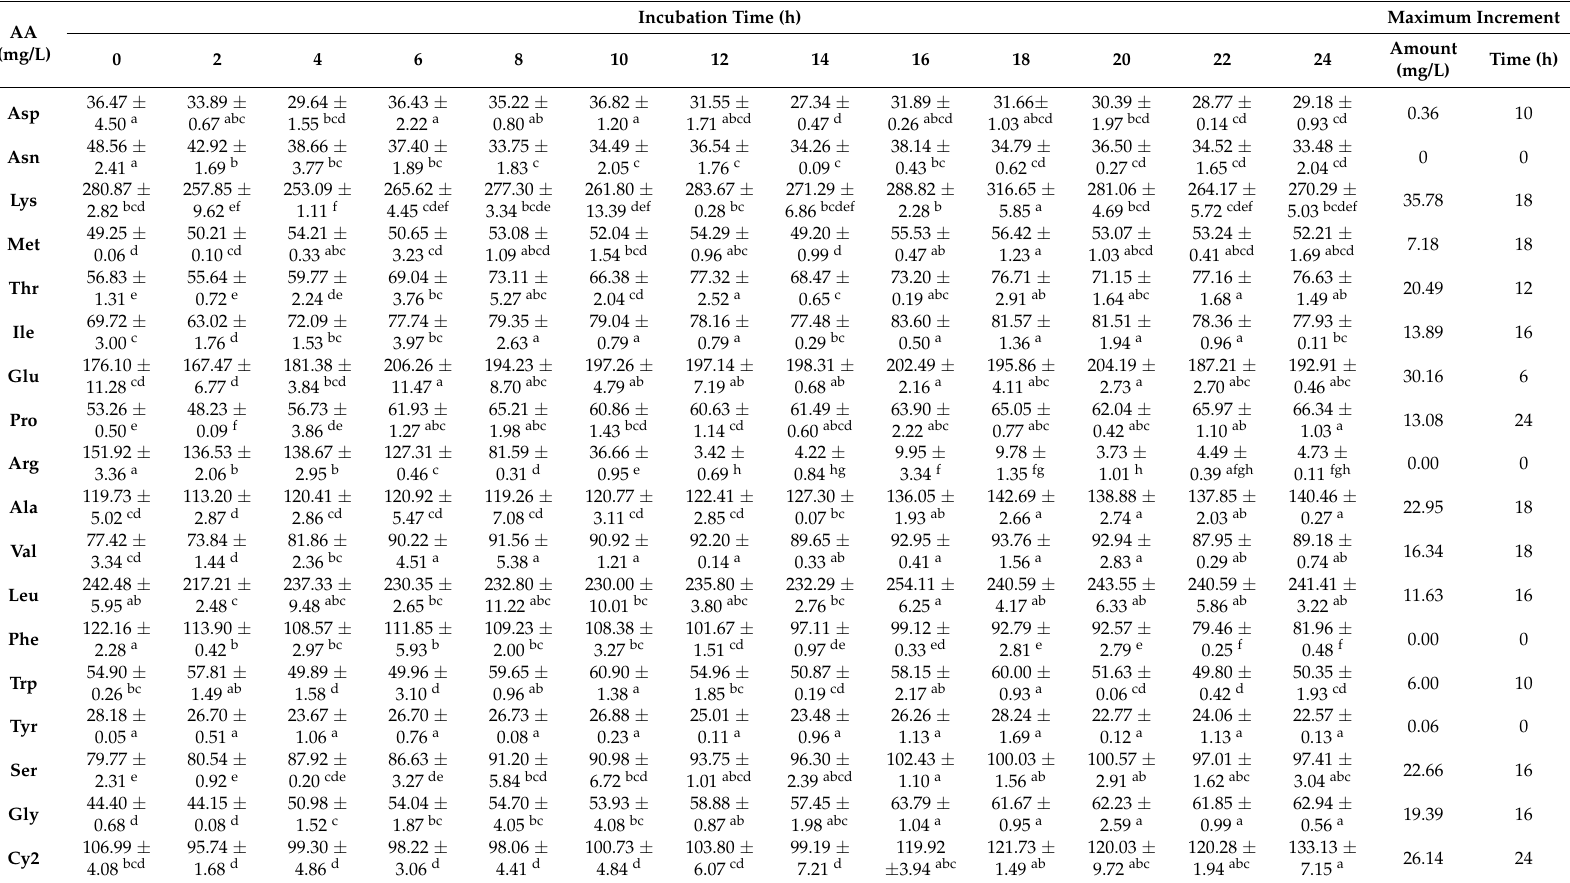
Table 3. The amino acid production profile of P. acidilactici